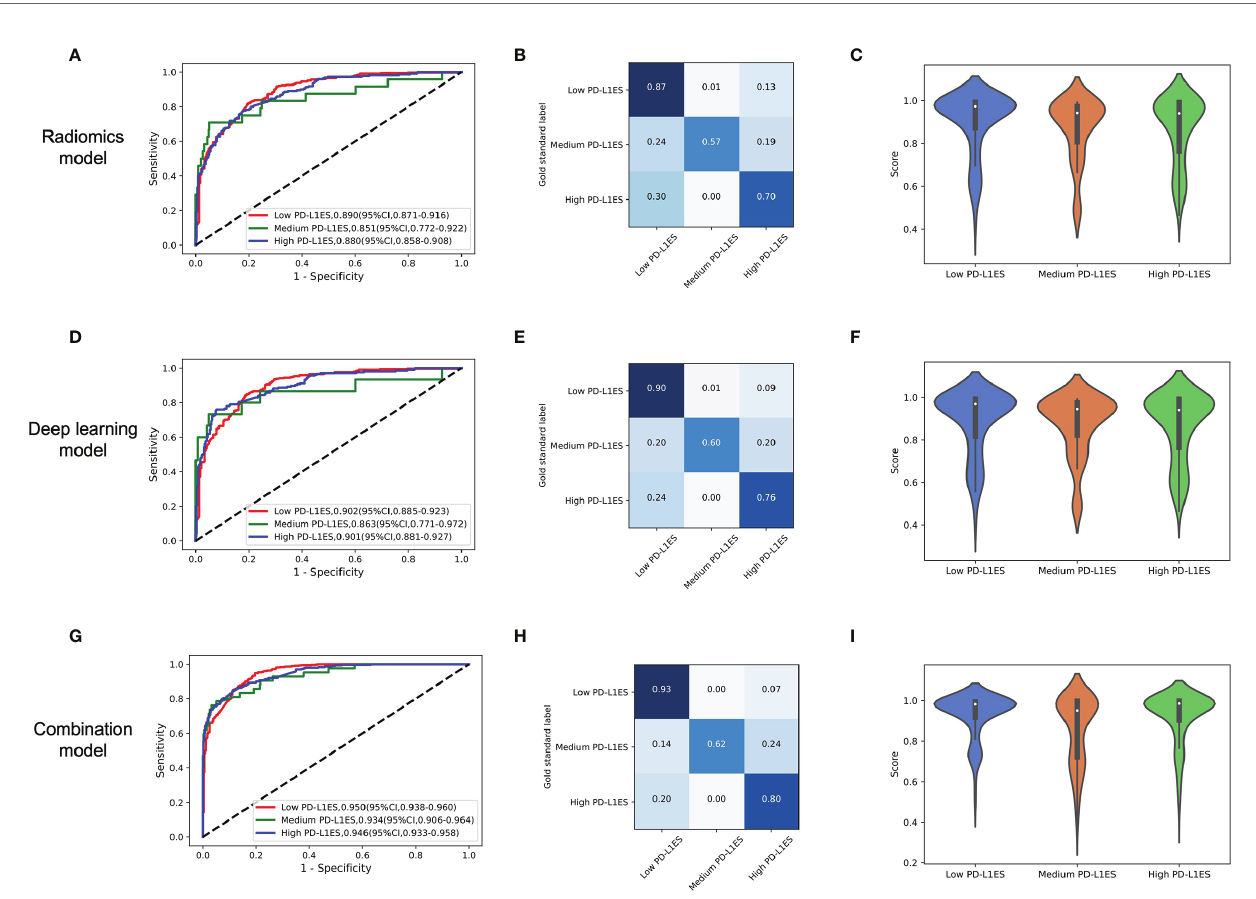
FIGURE 2 | The model performance in the prediction of PD-L1ES. The fi gure contained three groups of result analysis, including ROC curve, confusion matrix, and score distribution. The red line depicted low PD-L1 expression performance, the green line depicted medium PD-L1 expression performance, and the blue line depicted high PD-L1 expression performance. (A – C) The performance of the radiomics model. (D – F) The performance of the deep learning model. (G – I) The performance of the combination model. PD-L1ES, PD-L1 expression